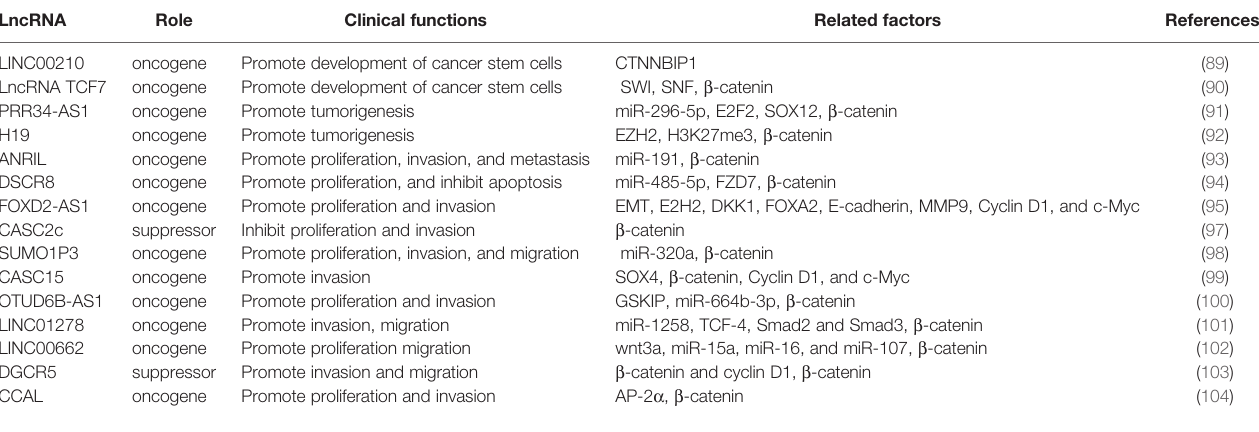
TABLE 2 | Role and clinical functions of lncRNAs in